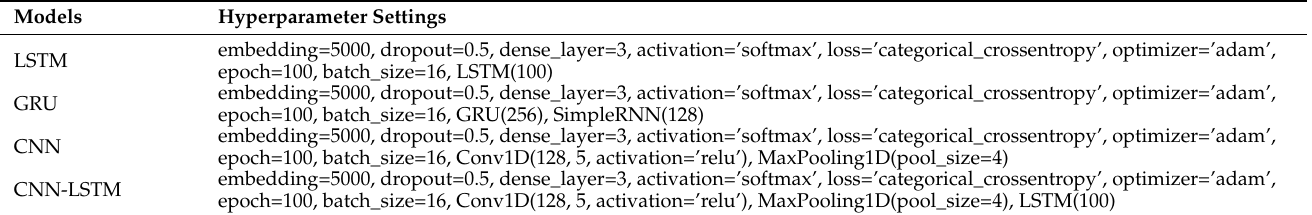
Table 15. Deep Learning Models’ Hyperparameter Settings.